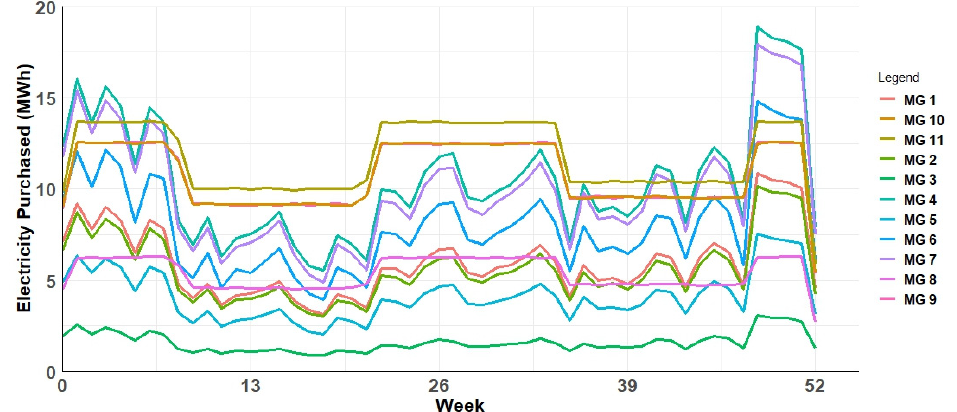
Figure 11. Weekly electricity sold (Mwh) at each microgrid through a one-year time period.